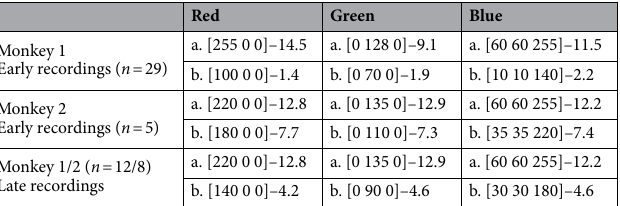
Table 1. Color values used for the 3 colored gratings across recording sessions and subjects, indicated as [RGB]—luminance (cd/m 2 ). a = Undimmed values, b = dimmed values.